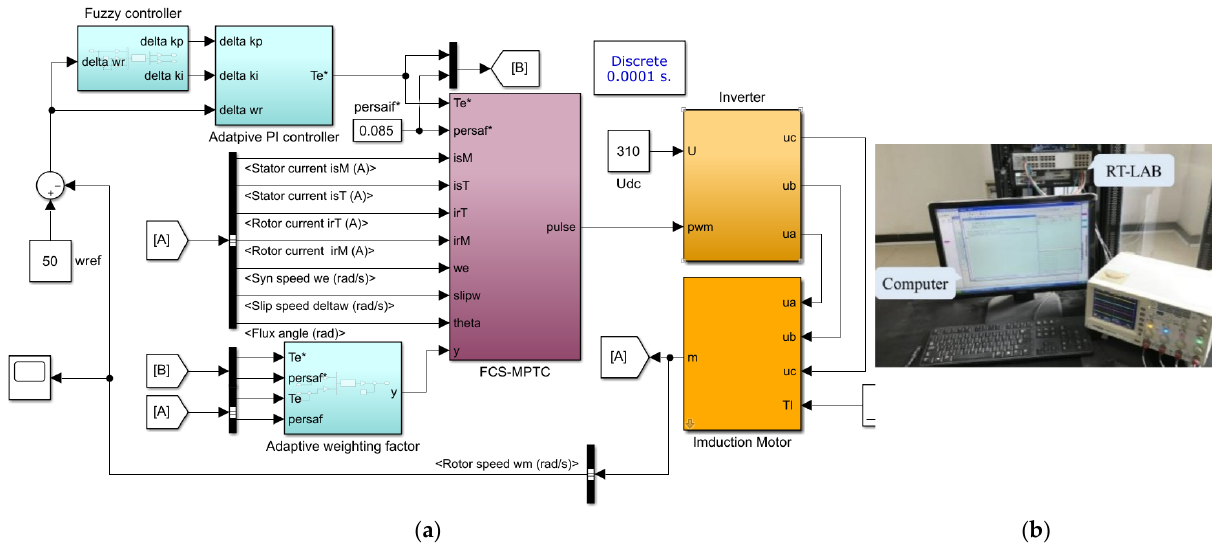
Figure 7. Setups for simulation and HIL test. ( a ) Simulation setup for the proposed FCS-MPTC method. ( b ) HIL testing setup for verifying the proposed FCS-MPTC method.